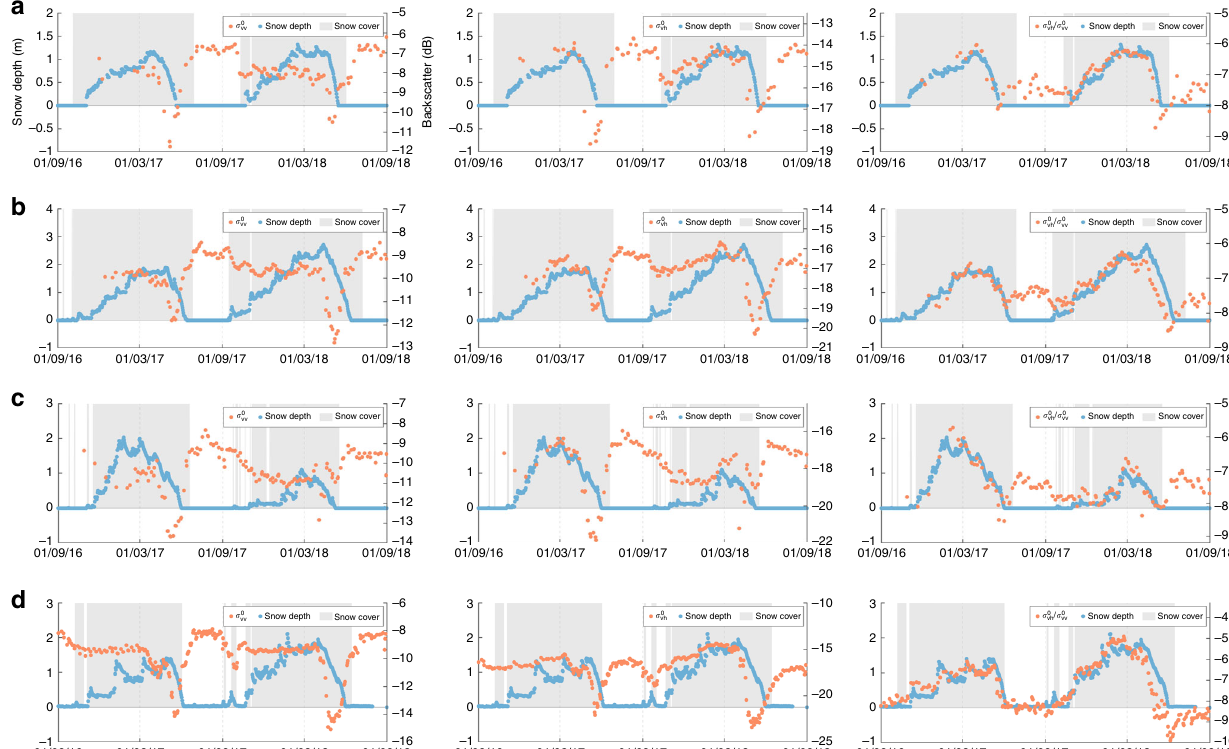
Fig. 3 Backscatter and snow depth time series at 4 sites. The left column shows the co-polarized backscatter ( σ 0 vv ; in dB), the middle column the cross- polarized backscatter ( σ 0 vh ; in dB), and the right column the cross-polarization ratio ( σ 0 vh / σ 0 vv ; in dB). Snow cover presence (dimensionless) from IMS is shown in gray. Site details, including mountain range and latitude/longitude/elevation: a Omineca Mountains, British Columbia, Canada (57.53°N/ − 126.73°E/1331 m), b Absaroka Range, Wyoming, USA (45.22°N/ − 110.24°E/2697 m), c San Juan Mountains, Colorado, USA (37.71°N/ − 107.51°E/3535 m), d European Alps, Austria (46.87°N/10.71°E/2464m). The ranges of the backscatter (dB) and snow depth (m) measurements have been adjusted between sites to improve